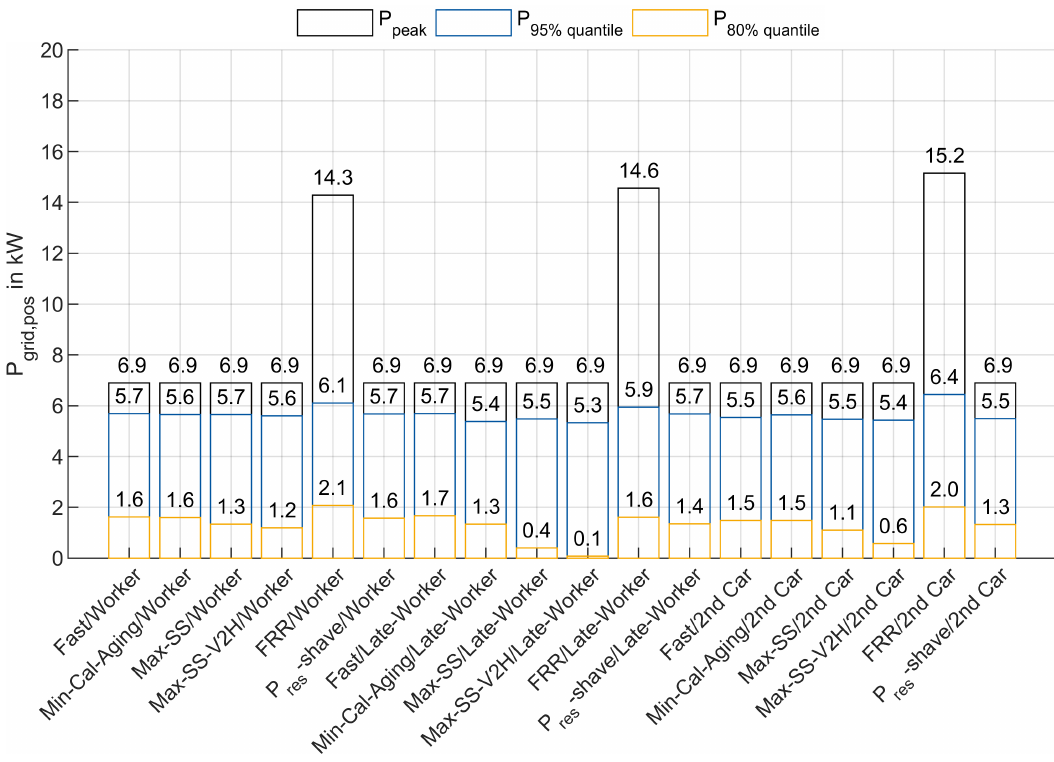
Figure A5. Negative power exchange of the household with the grid for workplace and home charging scenario H + W without SoC V 2 XLimit .